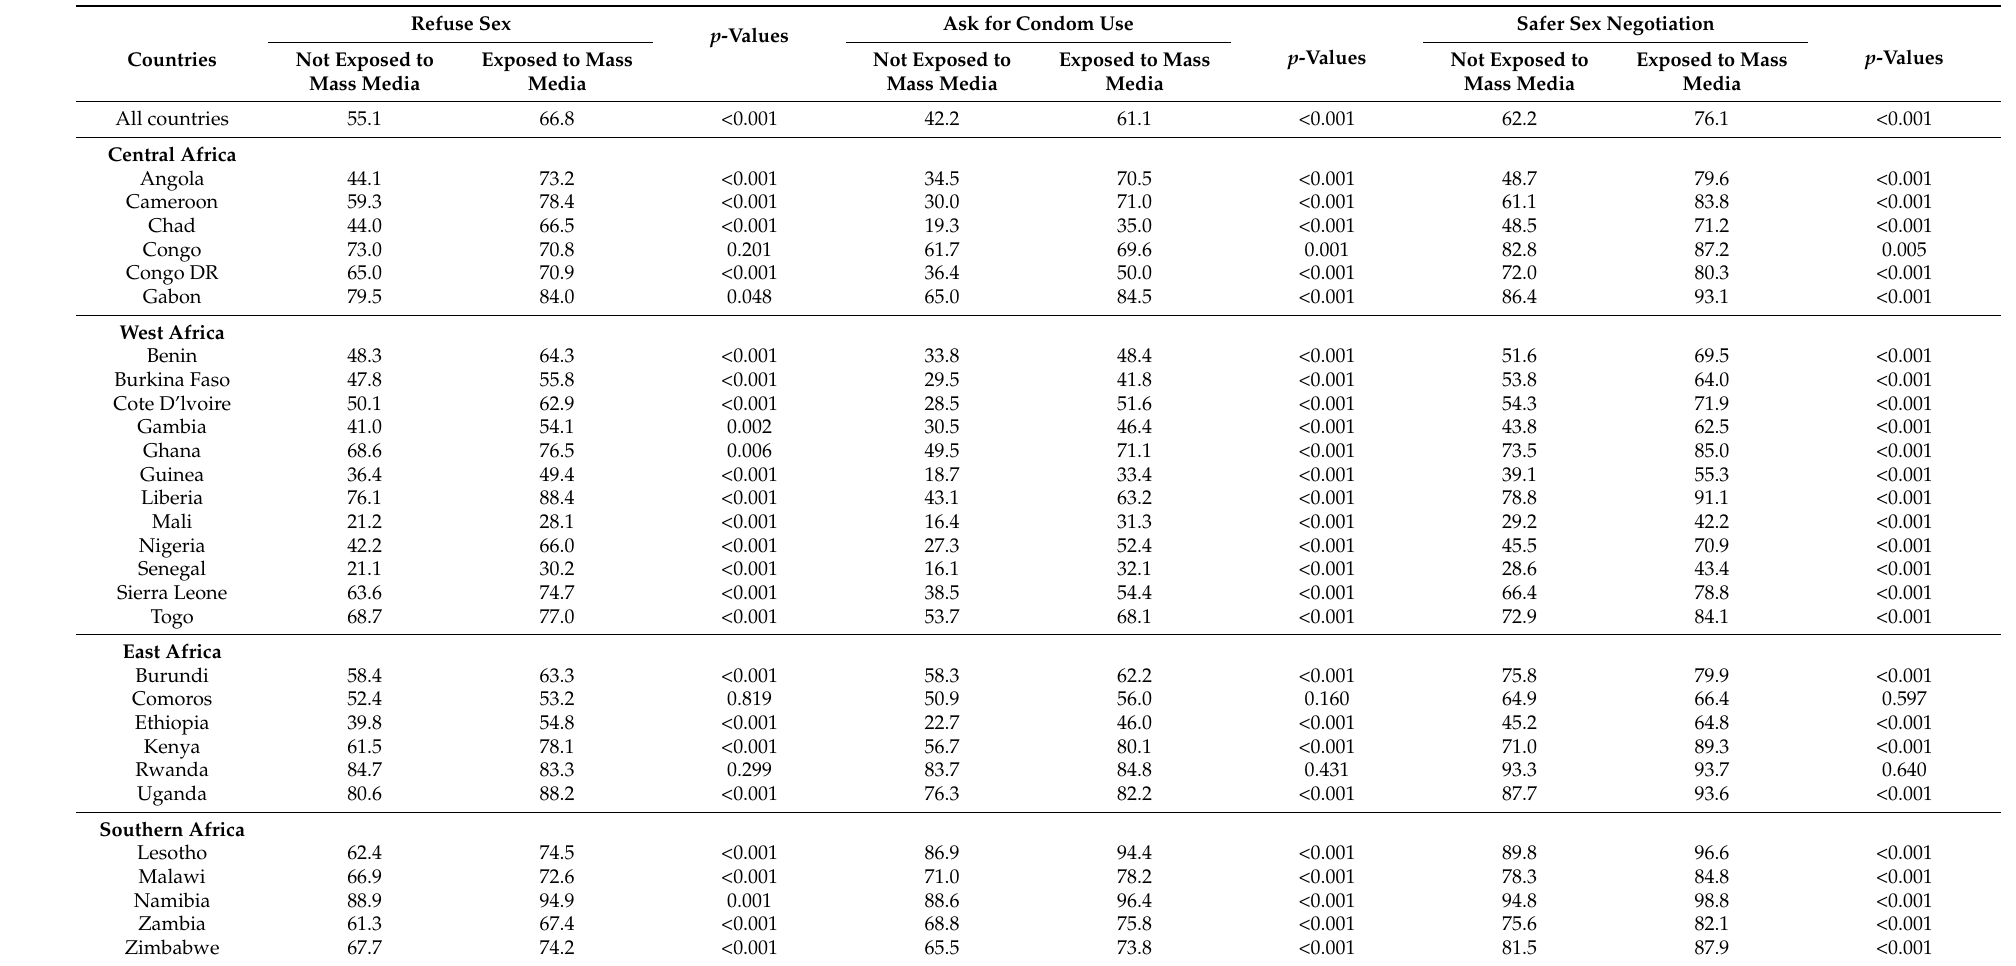
Table 3. Mass media and refuse sex, condom use, and safer sex negotiation by